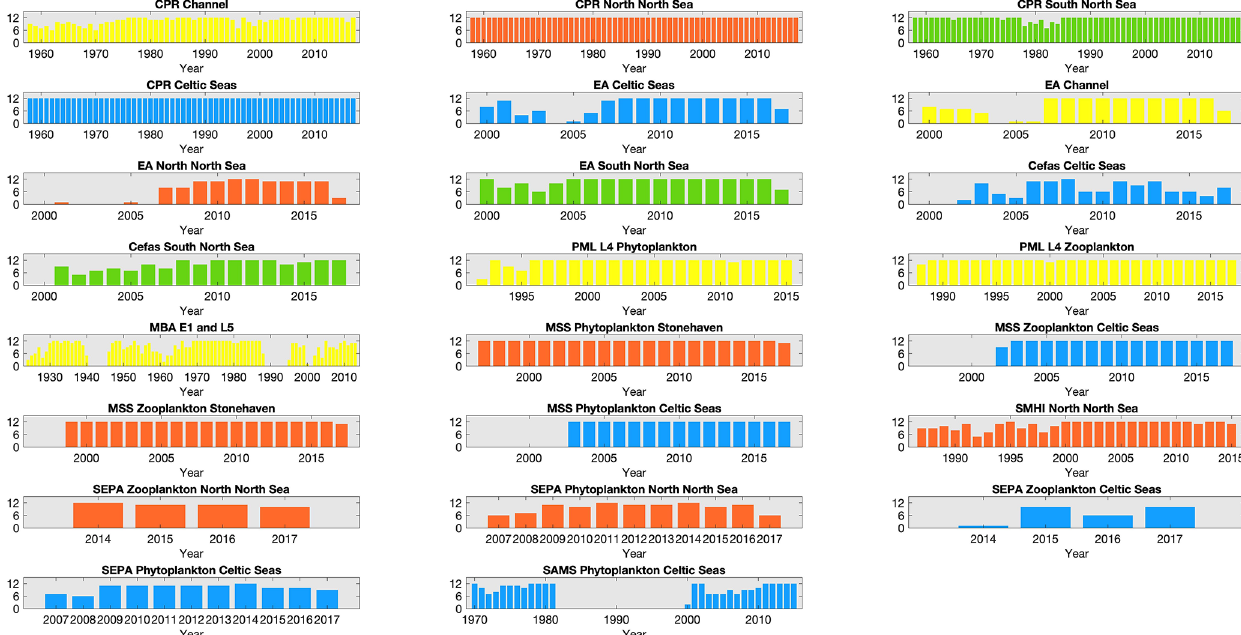
Figure 3. Number of months sampled per year for each dataset within each region: number of months sampled within each year, for each dataset within each of the regions defined in Fig. 1, except for MSS stations in the northern North Sea where only Stonehaven is shown as an example of the three MSS stations in that region. Widths of the bars indicate the total time-series length. Bar colour indicates spatial region (see Fig. 1); blue: Celtic Seas; red: northern North Sea; green: southern North Sea; light yellow: English